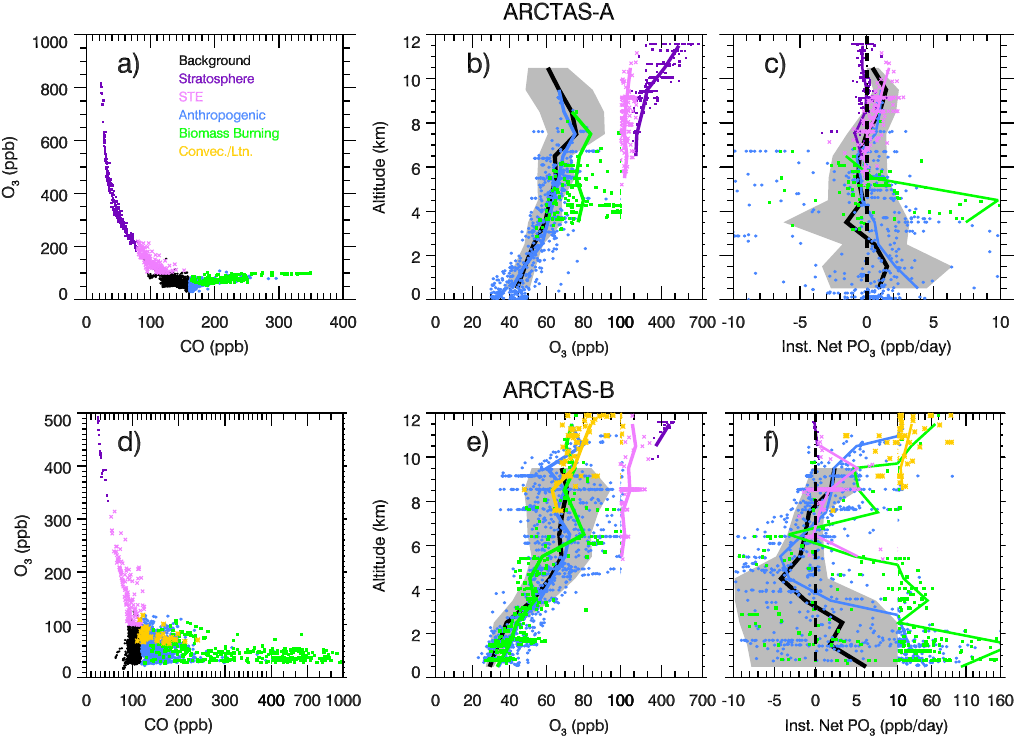
Fig. 11. (a) : scatter plot of O 3 vs. CO during ARCTAS-A. (b) : vertical profiles of O 3 during ARCTAS-A. (b) : vertical profiles of instan- taneous NP(O 3 ) during ARCTAS-A. Similar to Fig. 3, the background air is shown in black and the individual air masses are highlighted in color: stratosphere (purple), stratosphere-troposphere mixed (lilac), anthropogenic pollution (blue), biomass burning (green), and convec- tion/lightning (yellow) (d–f) are the same as (a–c) but for